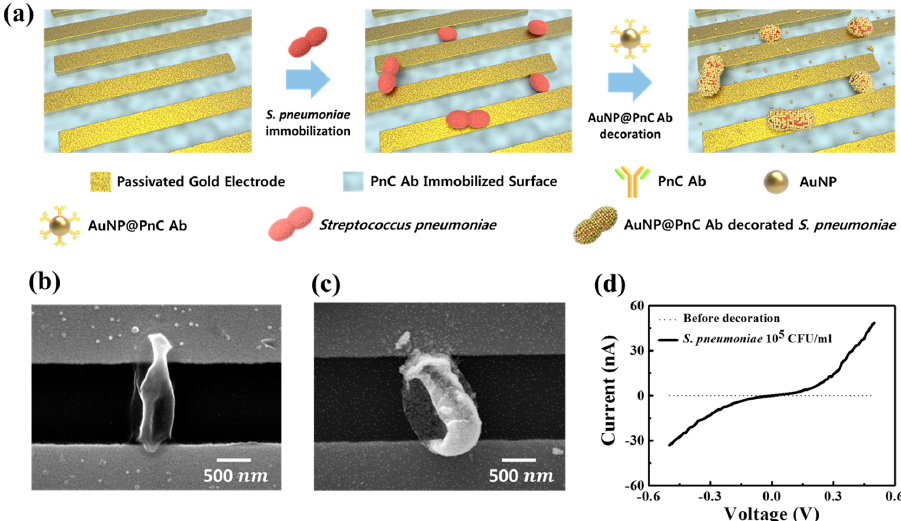
Figure 1. ( a ) The schematic diagram of the nanoparticle decoration method for the detection of S. pneumonia ; ( b ) SEM images after immobilization of S. pneumoniae and ( c ) after nanoparticle decoration; ( d ) the I-V characteristics after cell immobilization (dotted line) and after AuNP@pneumococcal C-polysaccharide (PnC) antibody probes decoration on the cell surface (solid line).